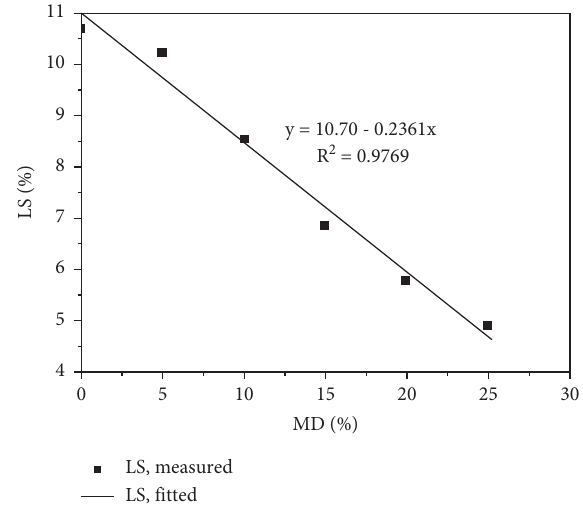
Figure 15: Results of linear shrinkage tests .